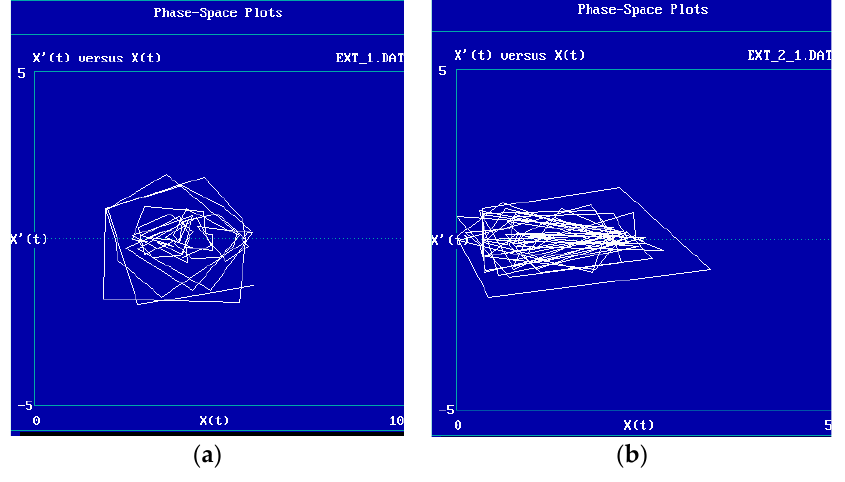
Figure 4. ( a ) Example of attractor reconstruction: Extraversion ratings a. Bob (Data correspond to Figure 2a). Notes: n = 76 valid points; estimated largest Lyapunov exponent: 0.585 ± 0.183; estimated correlation dimension: not computable. ( b ) Example of attractor reconstruction: Extraversion ratings a. Alice (data correspond to Figure 3a). Notes: n = 102 valid points; estimated largest Lyapunov exponent: 0.82 ± 0.16; estimated correlation dimension: 3.78 ± 1.25.